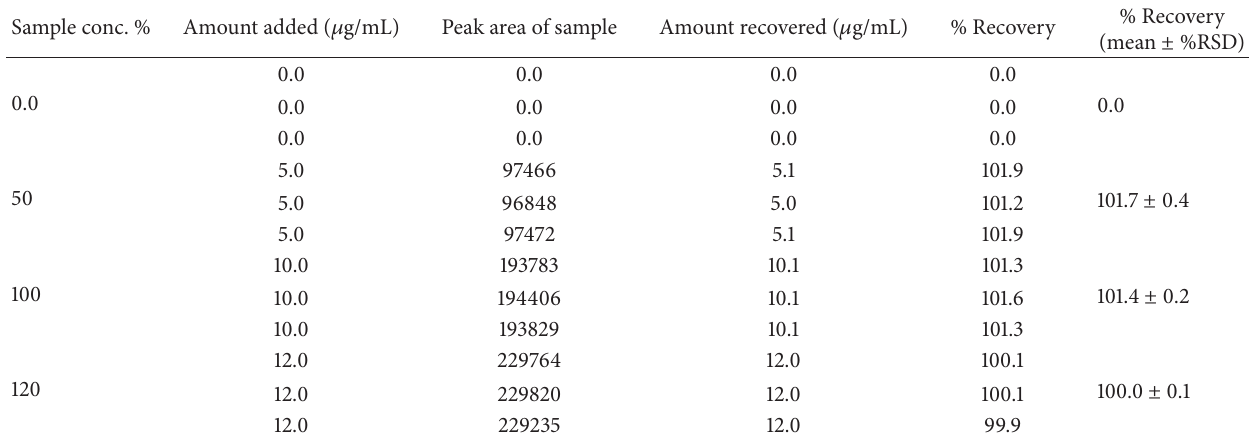
Table 3: Accuracy studies of RPS in drug-placebo solutions.